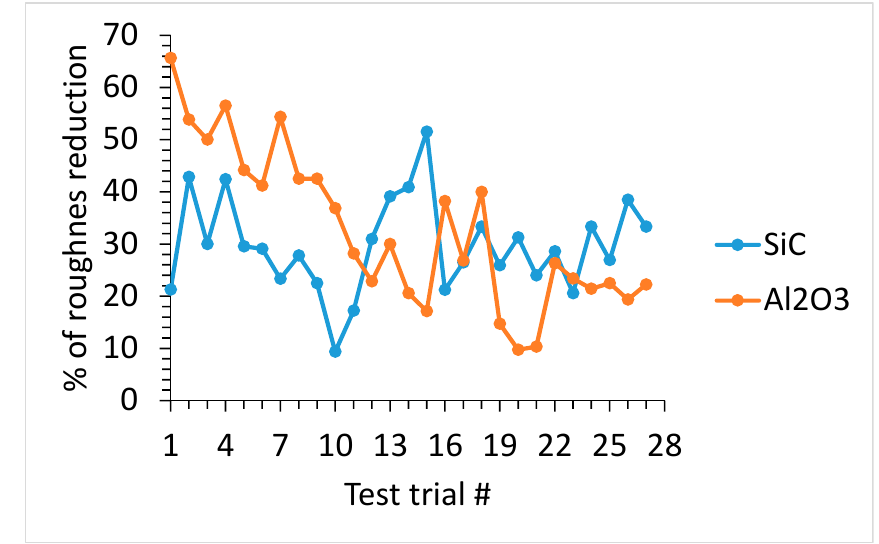
Figure 13. Comparison of percentage of roughness reduction between SiC and Al 2 O 3 abrasives with respect to test trials.